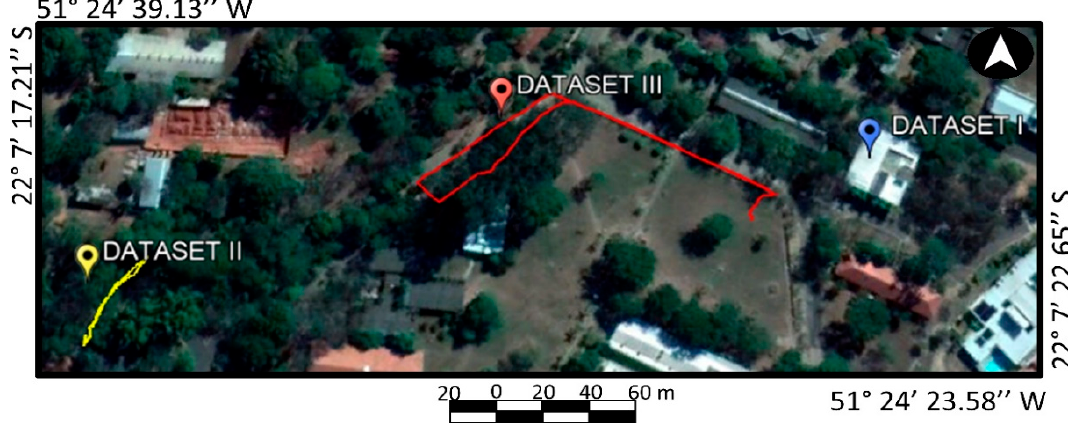
Figure 6. Test area at São Paulo State University: Indoor (data set I), forest (data set II), and urban Figure 5. Test area at S ã o Paulo State University: Indoor (data set I), forest (data set II), and urban (data (data set III) scenes. set III)